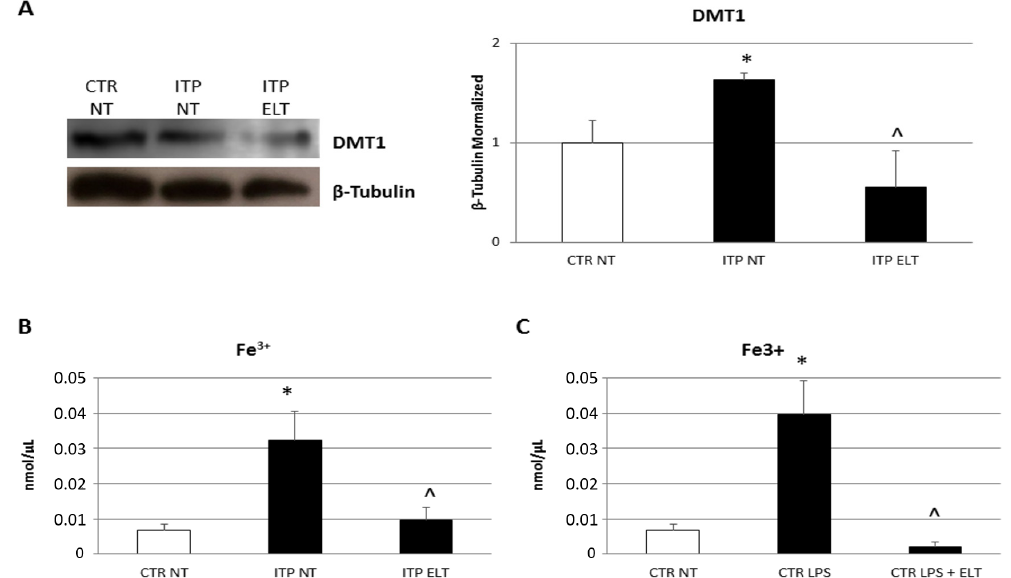
Figure 5. Effect of ELT on divalent metal transporter 1 (DMT1) protein expression and on Iron release. ( A ) DMT1 protein expression levels in ITP macrophages compared with CTR macrophages, determined by Western Blot, starting from 20 µ g of total lysates after treatment with ELT (6 µ M). The most representative images are displayed. The proteins were detected using Image Studio Digits software, and the intensity of immunoblots compared to the untreated control, taken as 1 (arbitrary unit), were quantified after normalizing with respective loading controls for the housekeeping protein β -Tubulin. Histogram shows DMT1 expression levels as the mean ± S.D. of independent experiments on each individual sample. A t -test was used for statistical analysis. * indicates p ≤ 0.05 compared to CTR NT, ˆ indicates p ≤ 0.05 compared ITP NT. ( B ) Fe 3+ intracellular concentrations (nmol/ µ L) in ITP macrophages compared with CTR macrophages, determined by Iron Assay, after treatment with ELT (6 µ M). Histogram shows Fe 3+ concentration as the mean ± S.D. of independent experiments on each individual sample. A t -test was used for statistical analysis. *indicates p ≤ 0.05 compared to CTR NT, ˆ indicates p ≤ 0.05 compared to ITP NT. ( C ) Fe 3+ intracellular concentrations (nmol/ µ L) in ITP macrophages compared with CTR macrophages, determined by Iron Assay, after treatment with LPS (500 nM) and LPS combined with ELT (6 µ M). Histogram shows Fe 3+ concentration as the mean ± S.D. of independent experiments on each individual sample. A t -test was used for statistical analysis. * indicates p ≤ 0.05 compared to CTR NT, ˆ indicates p ≤ 0.05 compared to CTR LPS.